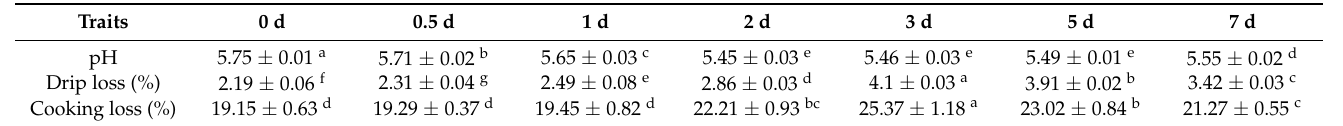
Table 1. Changes in quality characteristics of beef LL muscle during postmortem aging at 4 ◦ C (d 0, 0.5, 1, 2, 3, 5, and 7).